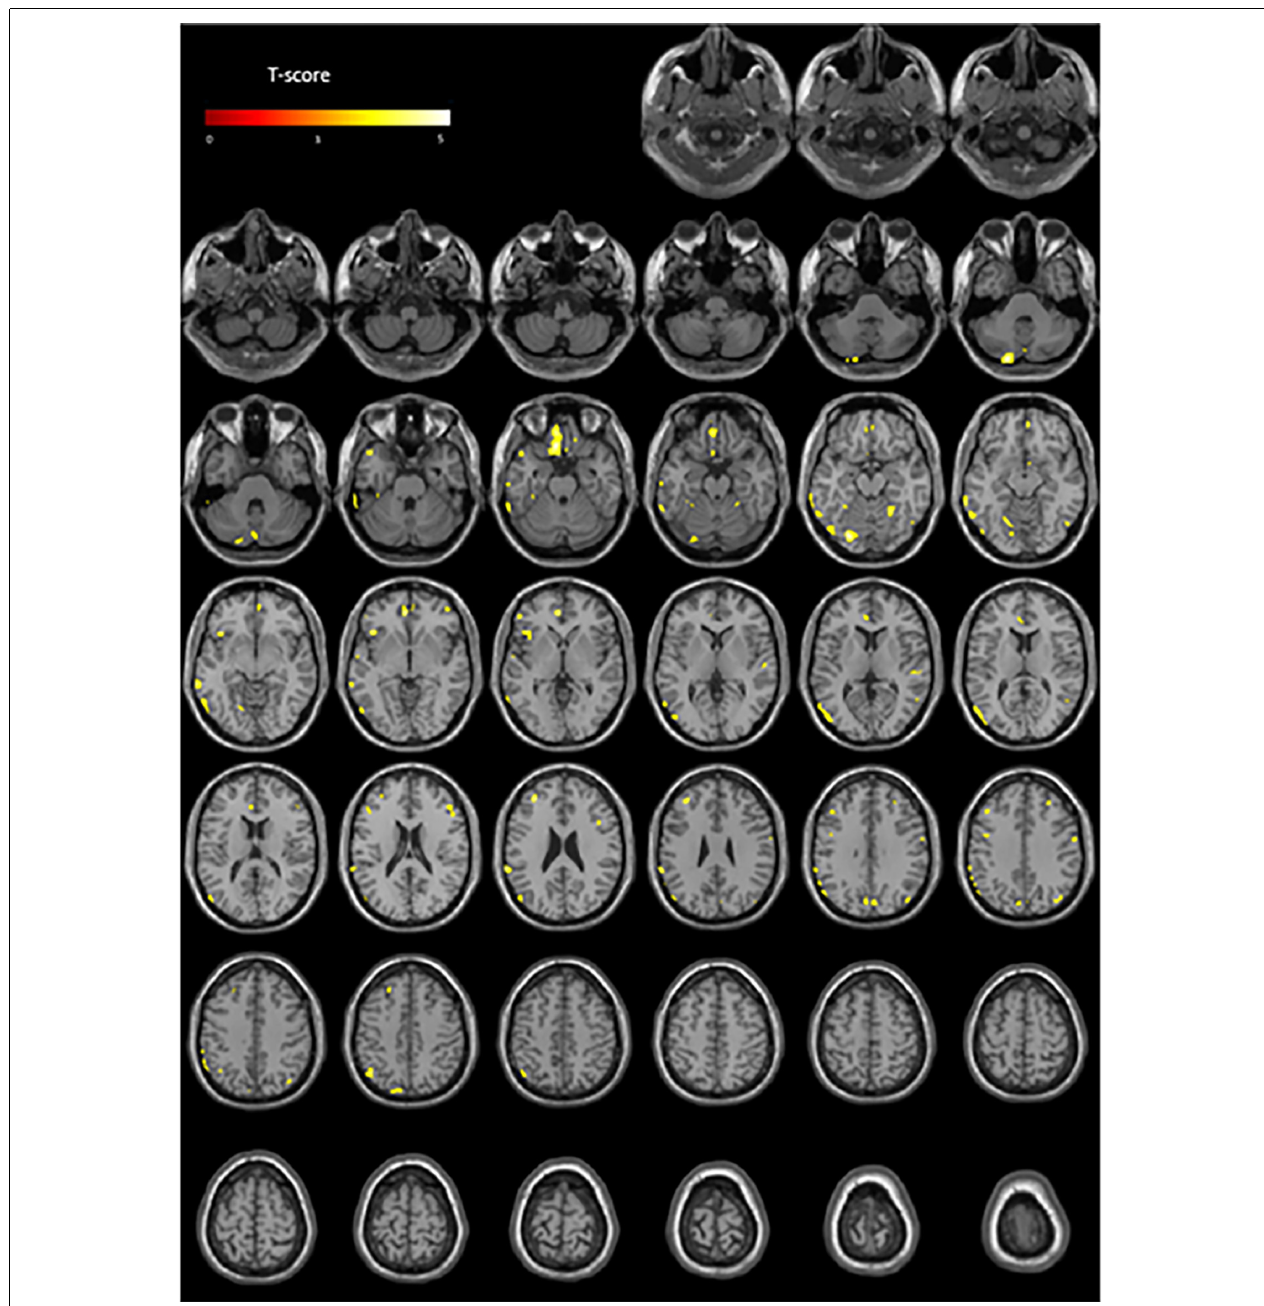
FIGURE 2 | Anatomical localizations of significant brain metabolic clusters associated with HR (negative association) in the whole population ( p < 0.001, uncorrected) projected onto two-dimensional slices of T1-weighted MRIs (from the base to the top of the